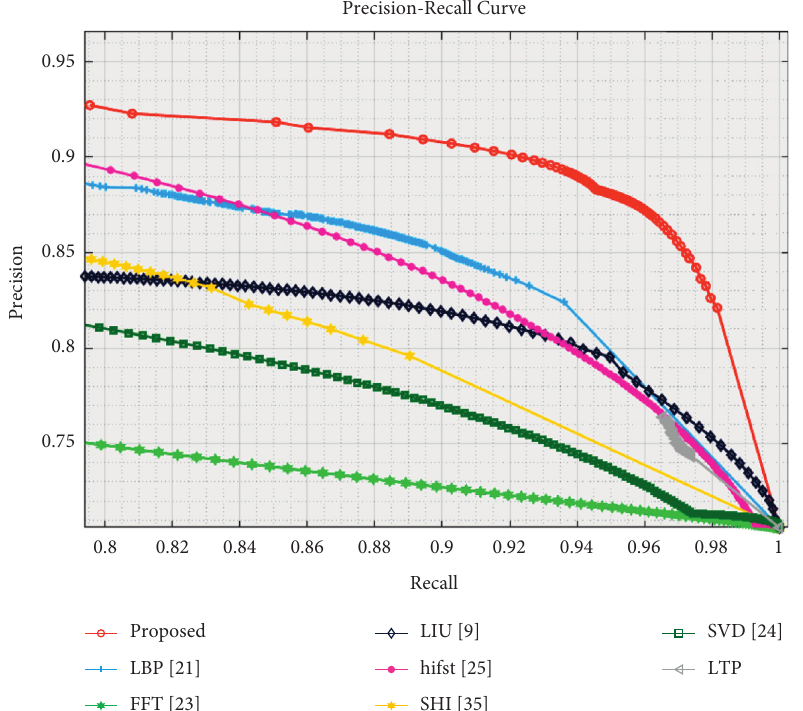
Figure 7: PR curve comparison on the Shi